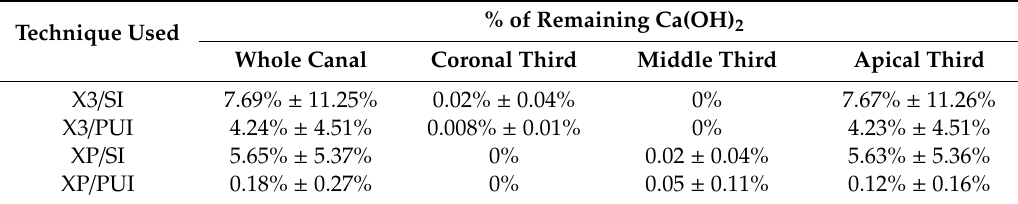
Table 2. The mean percentage of the volume of remaining Ca(OH) 2 in whole root canals and di ff erent thirds after using di ff erent removal